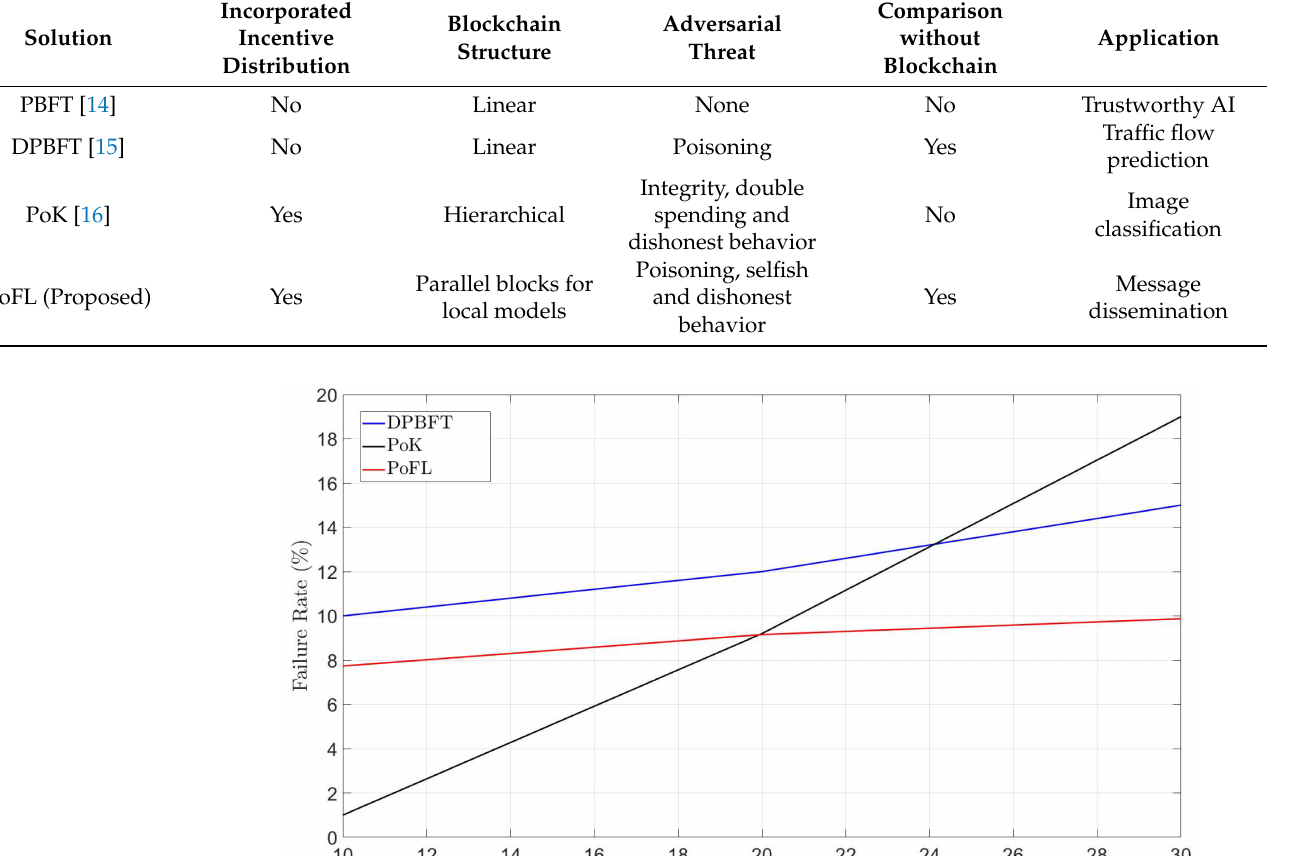
Table 1. Blockchain-enabled FL for vehicular networks.